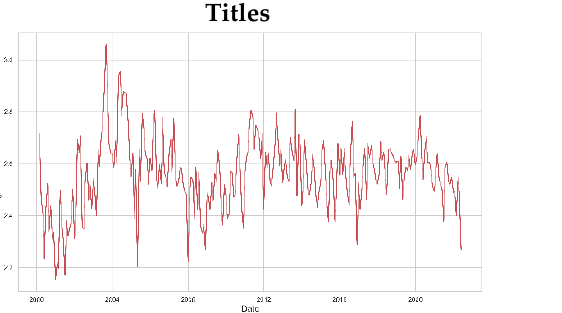
Figure A3. Sentiment analysis of news titles and leads over time for category “ Foreign ” news.